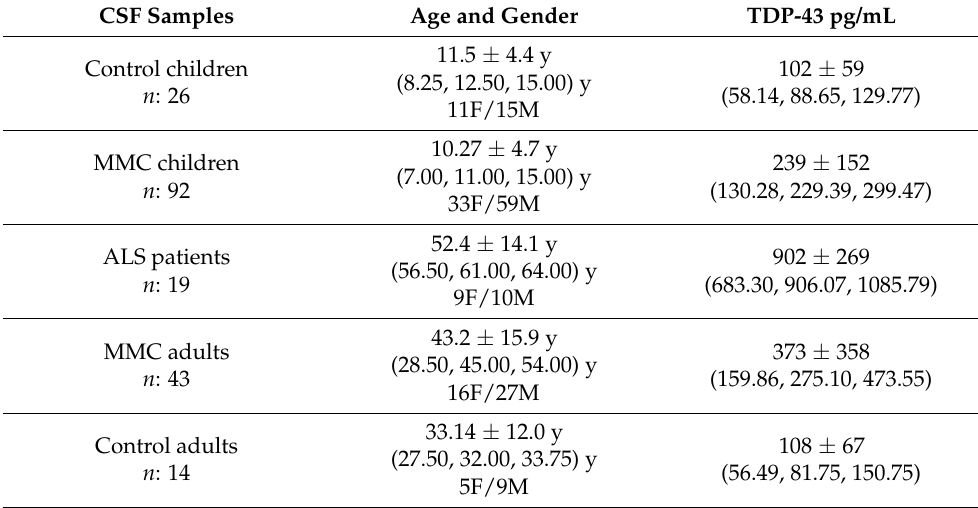
Table 1. CSF TDP-43 ELISA results in pg/mL for control and MMC children, ALS patients and adult MMC and low pollution controls. In each cell, the first row shows the mean ± SD and the second row the 25th percentile, median and 75th percentile.